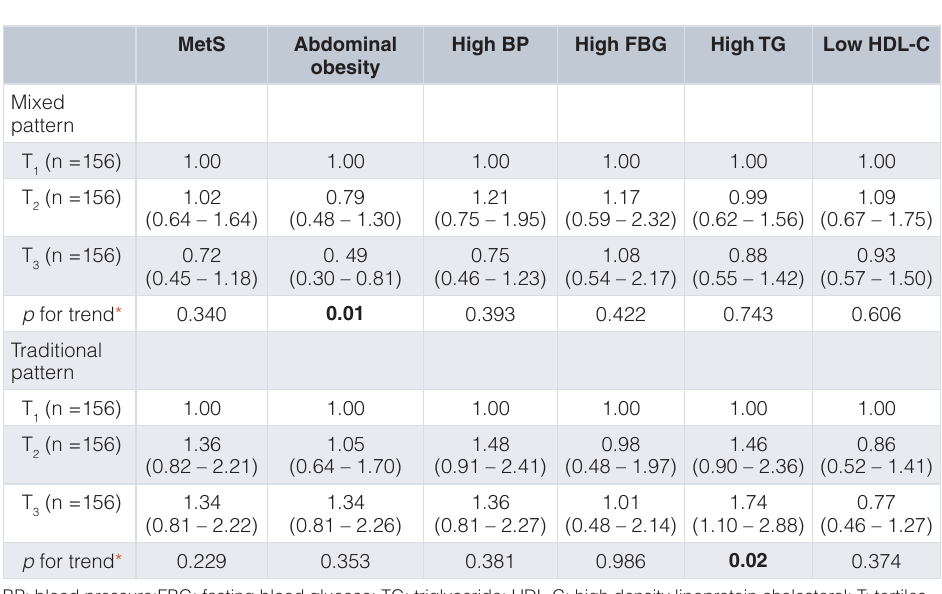
Table 5. Adjusted odds ratios (95% CI) for metabolic syndrome (MetS) and each component of MetS according to tertiles of each dietary pattern